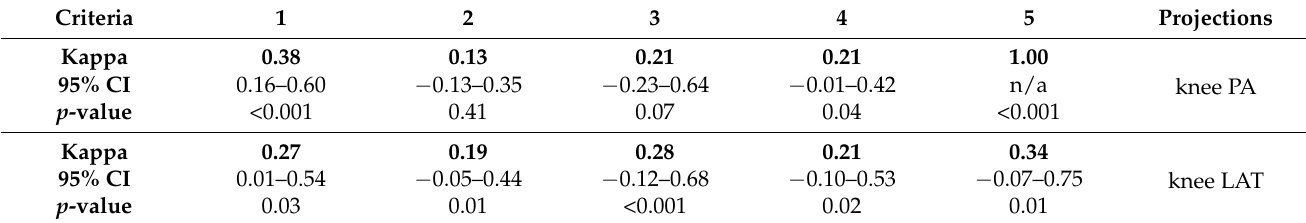
Table 9. Weighted kappa assessing intraobserver agreement for each image quality criterion in the knee PA/LAT protocol. Criteria